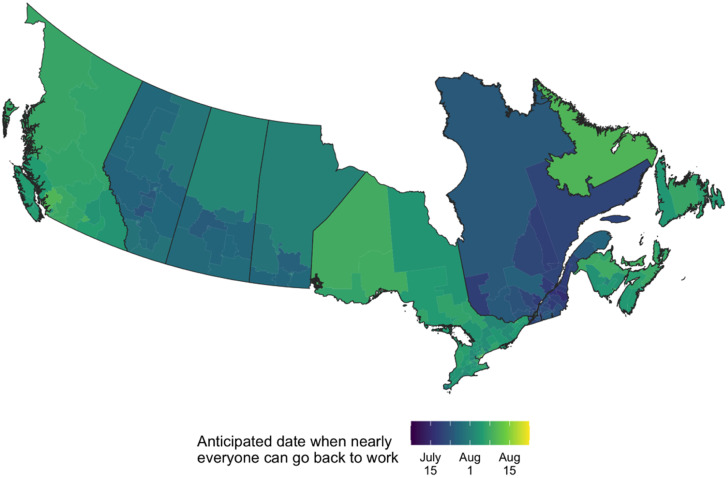
FED-level estimates.